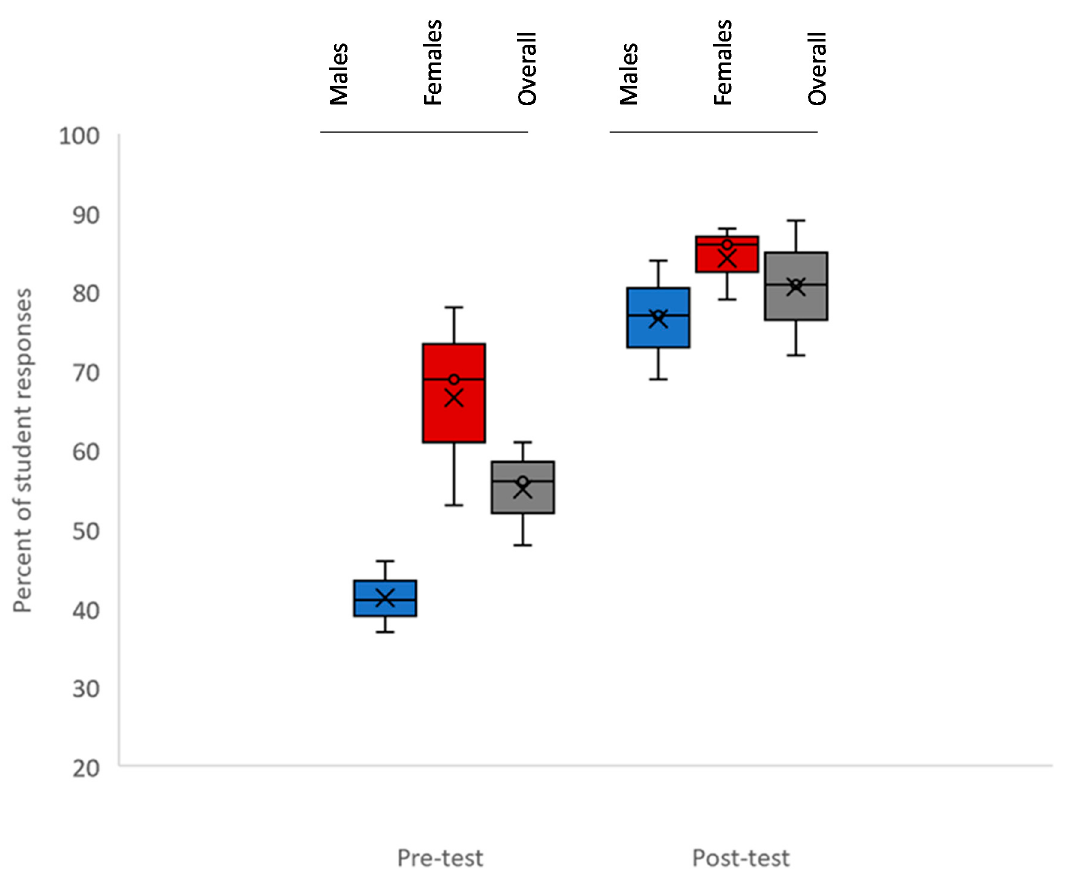
Figure 2. Percent of student responses indicating that vomestic violence (DV) or interpersonal violence (IPV) is a healthcare or dental issue (pre- and post). More than half of respondents in the pre-survey ( n = 119/232 or 51.3%) indicated that IPV or DV was a healthcare or dental issue, which was initially higher among females (average 69%) than males (41%), p = 0.041. Overall percentages of students who felt DV/IPV was a healthcare or dental issue rose to 81% in the post-test, with responses among males (77%) and females (86%) more closely aligned, p = 0.221.